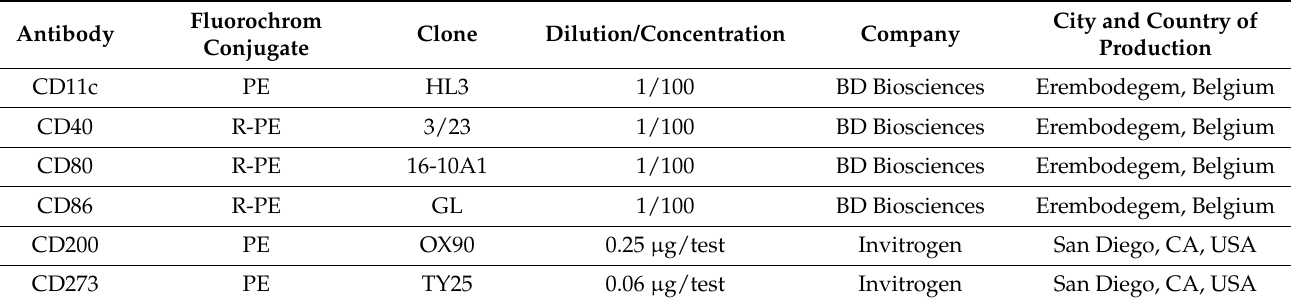
Table 1. Antibodies used for phenotypic analysis by flow